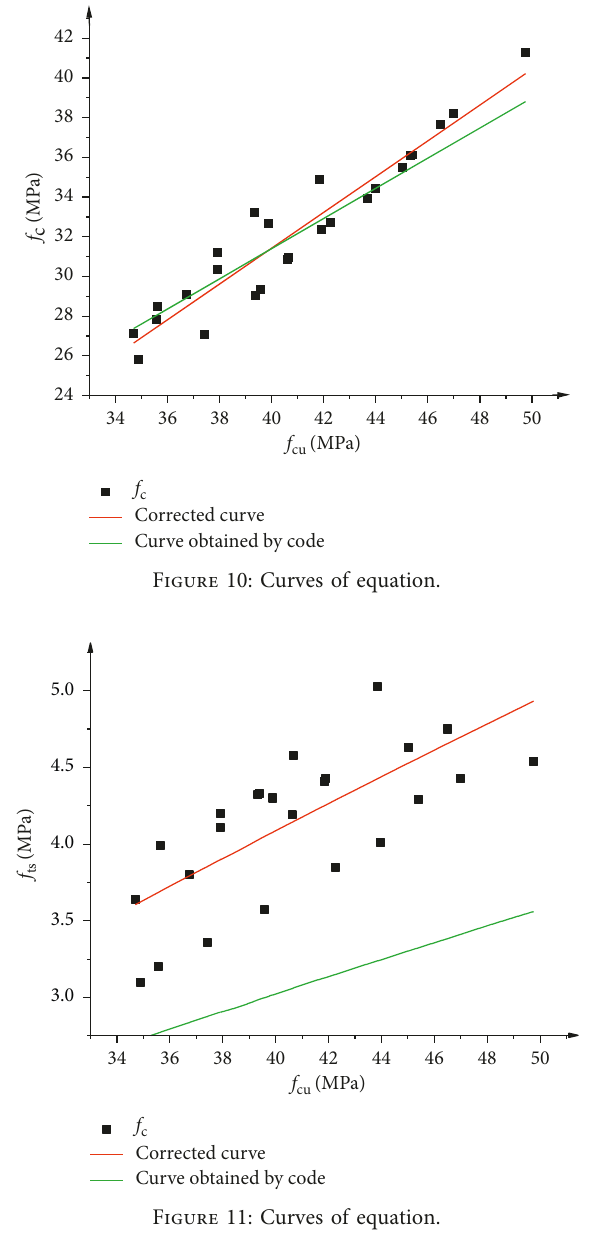
Figure 11: Curves of equation.